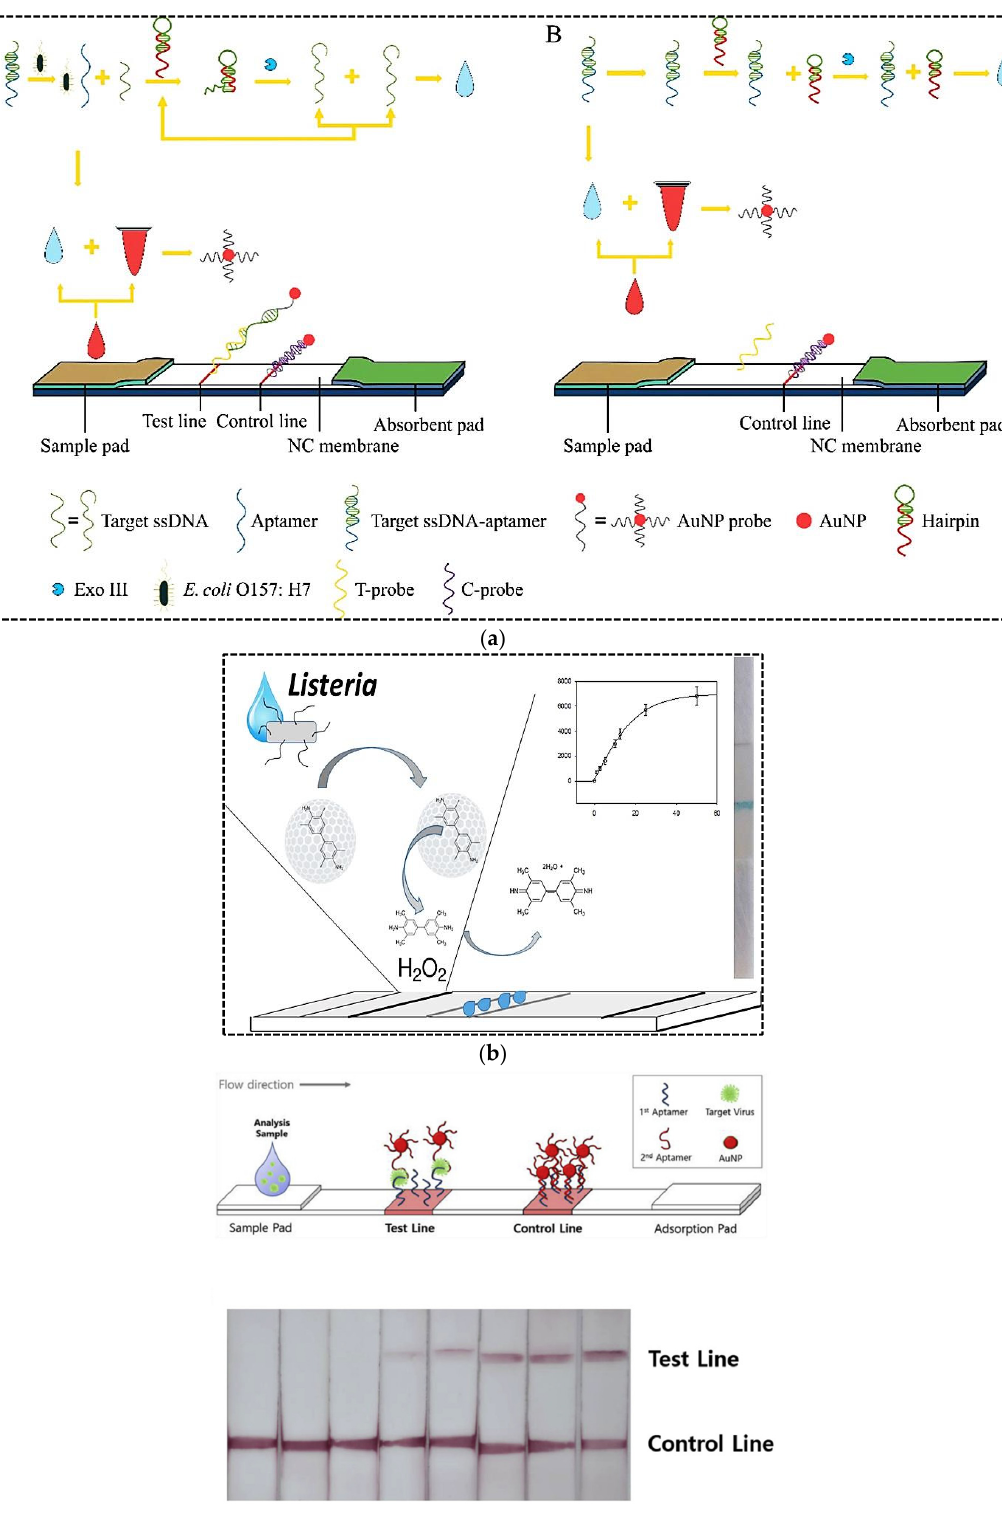
Figure 4. ( a ) Principle of aptamer-exonuclease III (Exo III)-assisted amplification-based LFA for the detection of E. coli O157:H7: ( A ) in the presence of target; ( B ) in the absence of target; ( b ) A LFA based on aptamer-gated silica nanoparticles and release of signal molecules for the detection of Listeria monocytogenes ; ( c ) whole virus particle detection using a sandwich LFA. Reprinted with permission from [49–51],